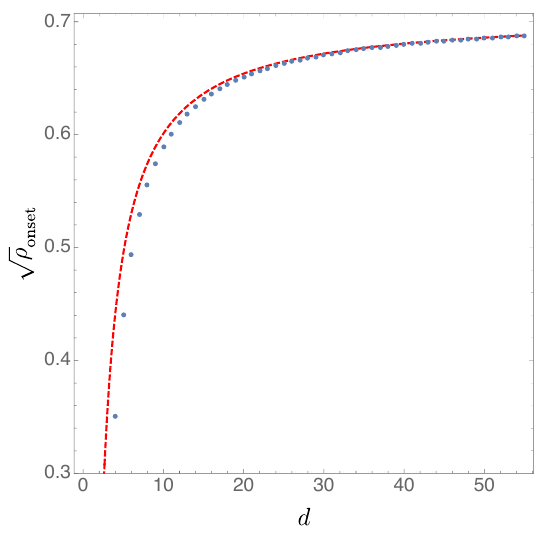
p Figure 5 . R onset =‘ d (cid:17) (cid:26) as a function of d : the blue disks represent our exact numerical onset data, and the dashed red line the analytic expression (3.19), valid at large d